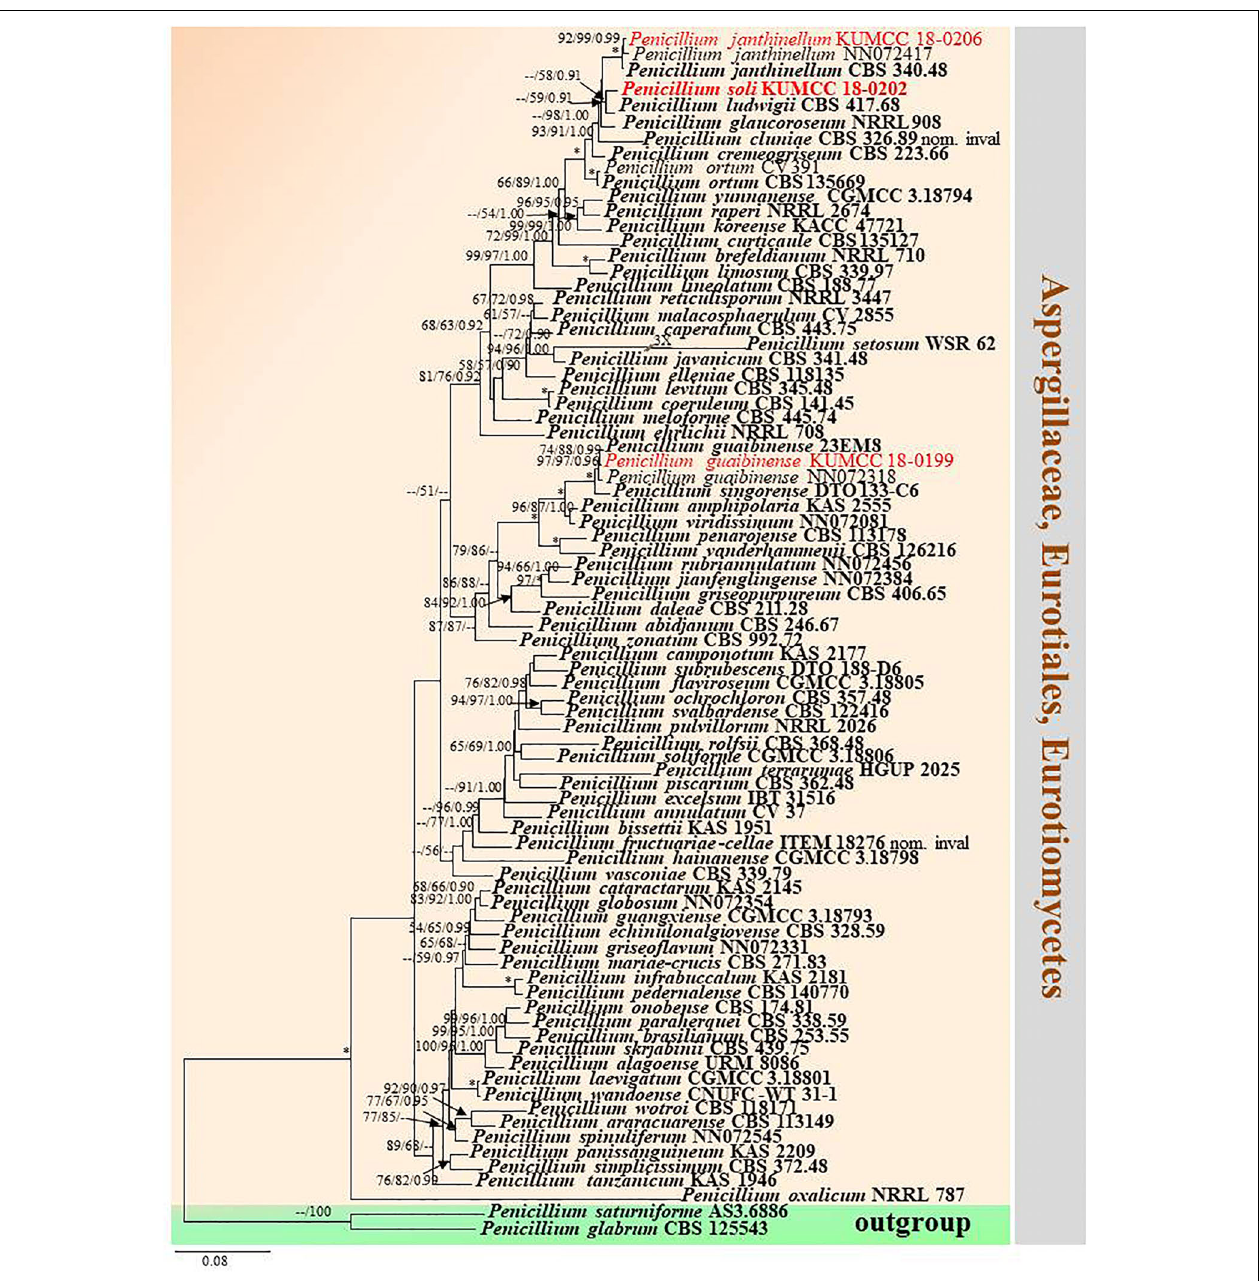
FIGURE 12 | Phylogram generated from maximum likelihood analysis based on combined ITS, BenA , CaM, and RPB2 sequence data. Eighty-one sequences are included in the combined analysis, which consisted of 2590 characters including alignment gaps. The tree is rooted to Penicillium glabrum (CBS 125543) and P. saturniforme (AS3.6886). The MP analysis for the combined dataset had 815 parsimony informative, 1358 constant, 417 parsimony uninformative characters and yielded 39 most parsimonious trees. The best-fit model GTR + I + G was selected for ITS, BenA and RPB2 , and SYM + I + G for CaM in BI analysis. Maximum parsimony and maximum likelihood bootstrap values ≥ 50% and Bayesian posterior probabilities ≥ 0.90 (MPBS/MLBS/BYPP) are indicated at the nodes. Branches with 100% MPBS, 100% MLBS and 1.00 BYPP values are indicated as an asterisk ( ∗ ). The ex-type strains are bolded black, and the new isolates are in red.